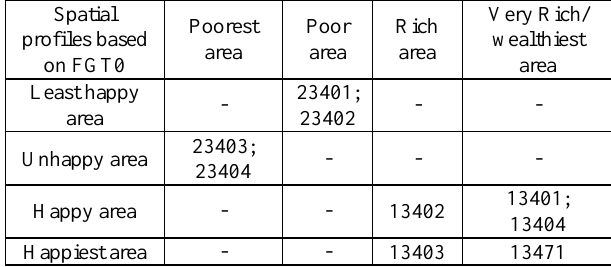
Table 5. Query Distribution of Spatial Profile based on